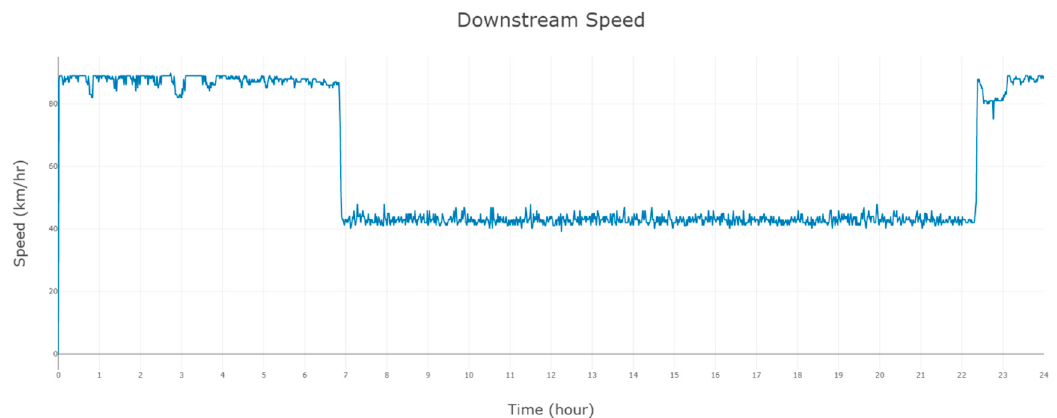
Figure 11. Average speed measured downstream of the ramp—no control scenario.